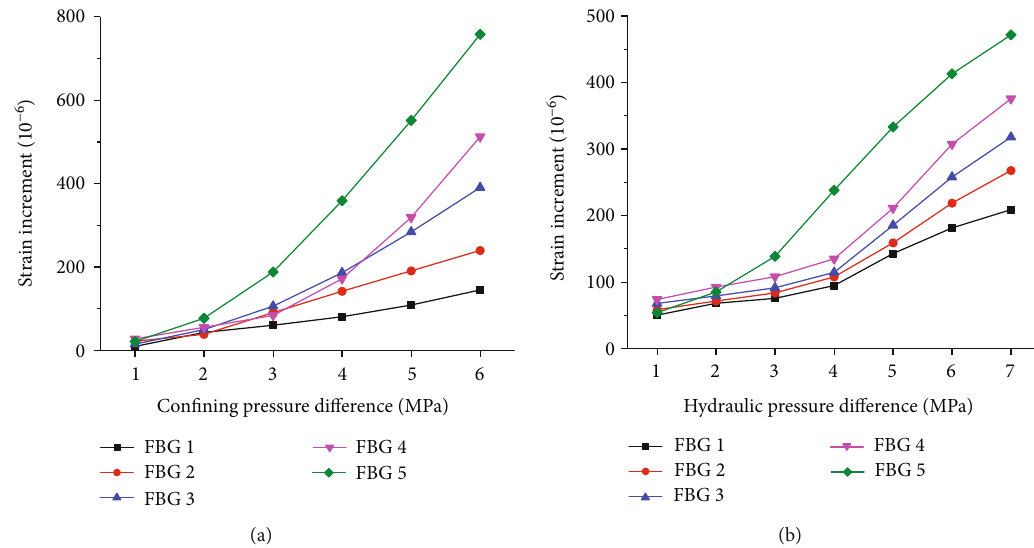
Figure 14: Strain monitoring results of microfracture surface with JRC = 10~12 : (a) relationship between strain measured at di ff erent points and con fi ning pressure di ff erence and (b) relationship between strain measured at di ff erent points and hydraulic pressure di ff